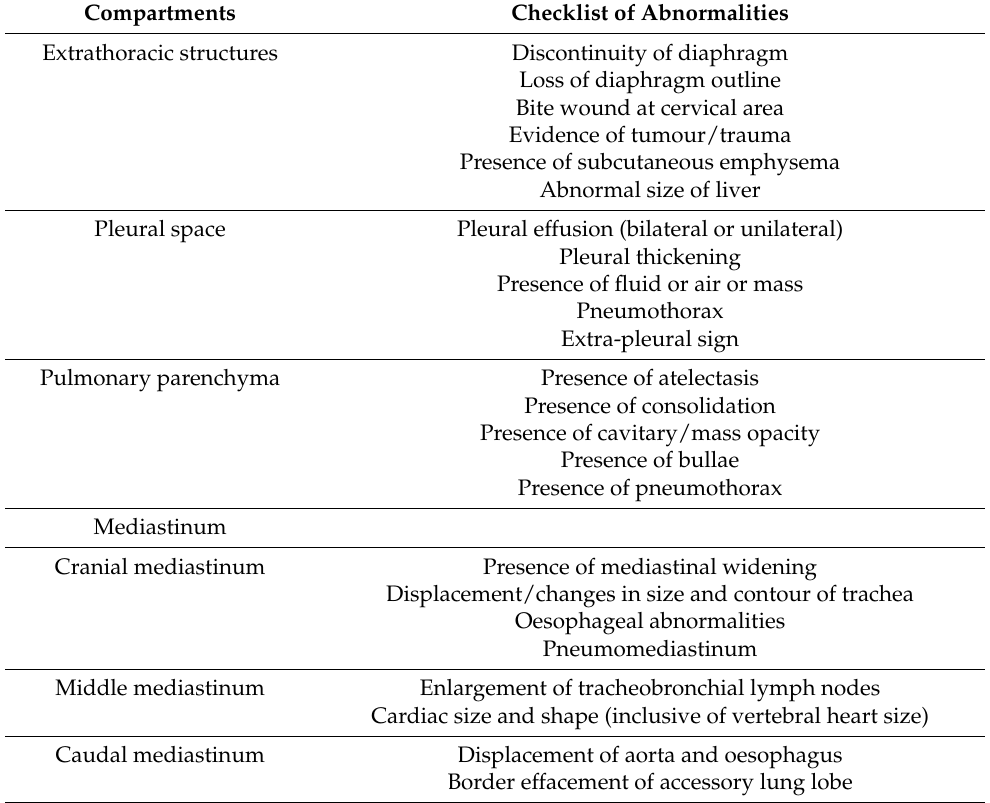
Table 1. Radiographic thoracic abnormalities